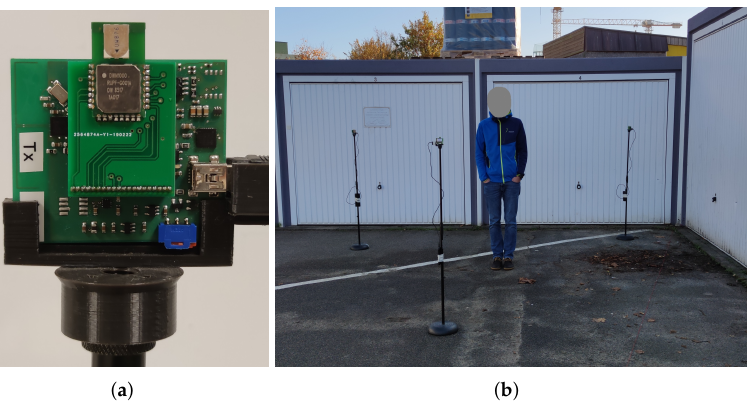
Figure 7. Sensor node and the test setup. ( a ) TinyTriSOS as our measurement equipment [31]. ( b ) Measurement setup in an outside